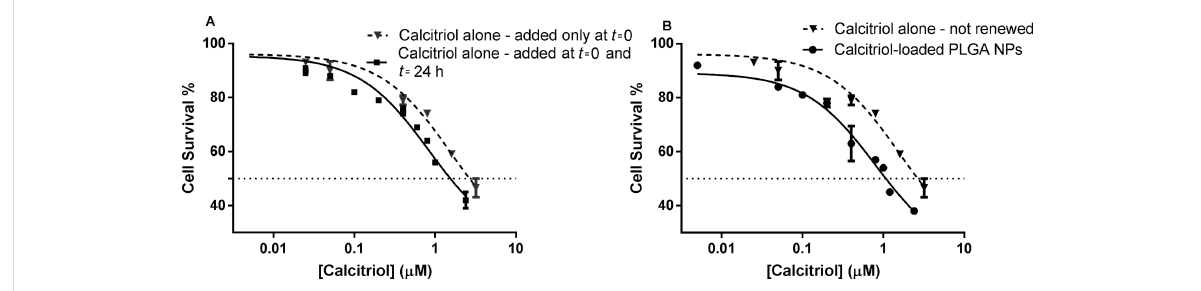
Figure 4: Effects of calcitriol after 48 h treatment on S2-013 cell survival, determined by SRB assay. (A) Comparison between a single-addition and daily renewal of calcitriol; (B) Comparison between calcitriol free (single-addition) and entrapped in PLGA NPs. Free calcitriol, added only at t = 0, is represented with triangles and a dotted line; free calcitriol, added at t = 0 and t = 24 h, is represented with squares and a solid line; and calcitriol–NPs with spheres and a solid line.